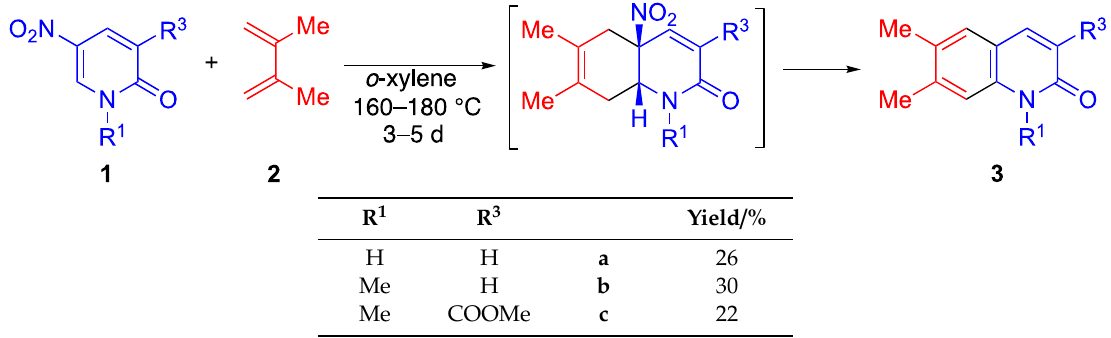
Table 2. D-A reaction of 5-nitropyridones 4 accompanying elimination of the nitro